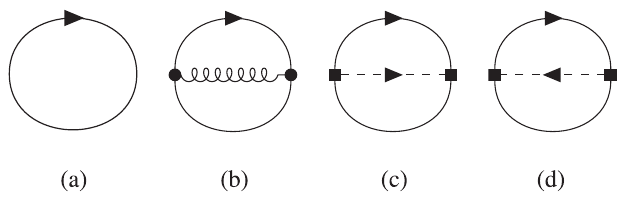
FIG. 5. Diagrams contributing to the denominator D [Eq. (B3)] of h O 1 i ¼ h S a ð τ Þ S a ð 0 Þi . The oriented line denotes the trajectory of the SU( M 0 j M ) superspin in imaginary time, a filled circle is a γ 0 vertex, and a filled square is a g 0 vertex. The spiral curve denotes the ϕ propagator, and the dashed curve represents the ψ